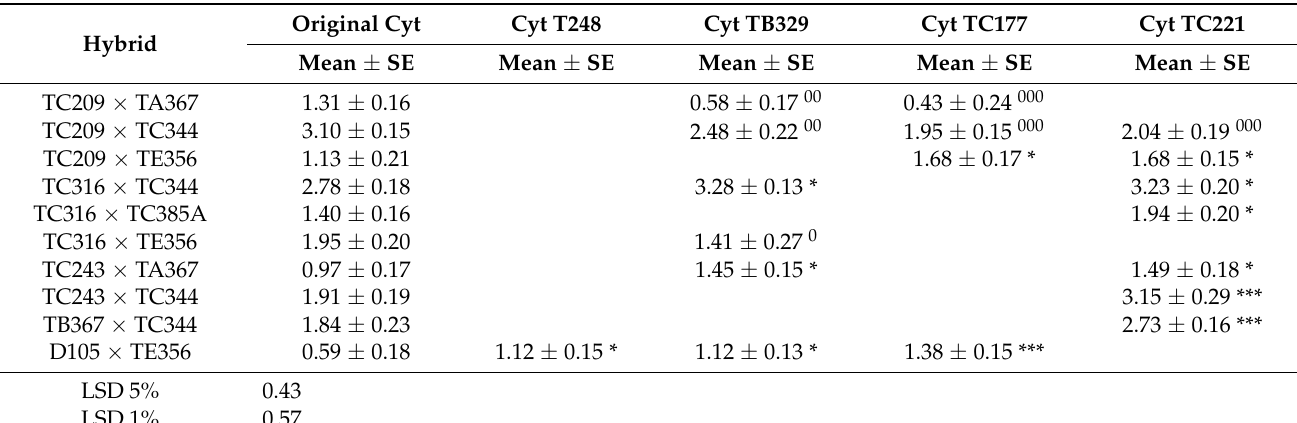
Table 9. The influence of cytoplasm × nucleus × tester interaction on some hybrids’ β -cryptoxanthin content ( µ g/g)—ANOVA